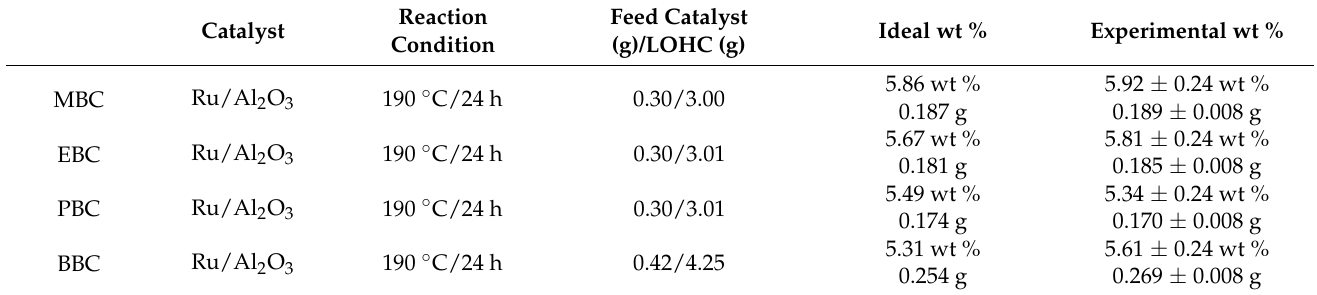
Table 2. Catalytic hydrogenation of MBC , EBC , PBC , and BBC .